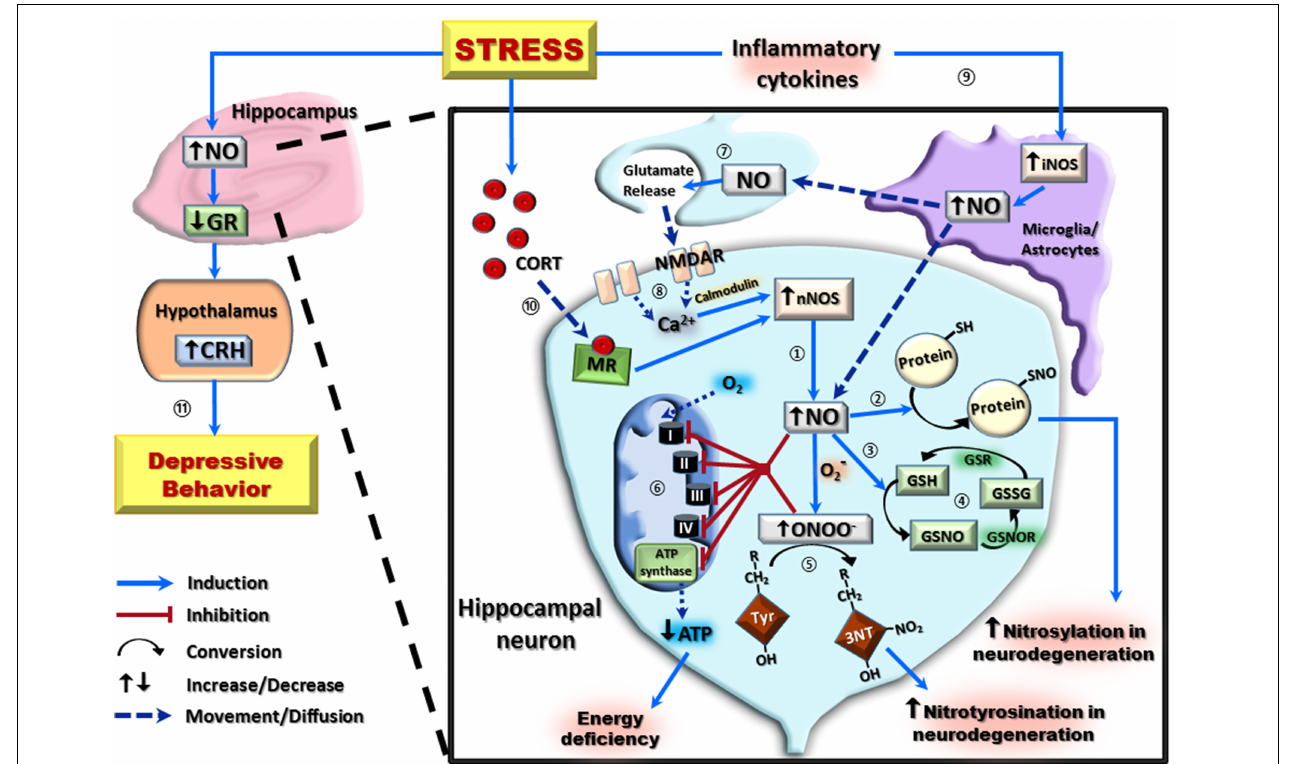
deficiency by inhibition of all components of the electron transport chain (Complex I–IV), including ATP synthase, resulting in decreased ATP production ⑥ . Both post-synaptically produced NO, and NO produced by the inducible isoform of nitric oxide synthase (iNOS), can act as a neurotransmitter on pre-synapticneurons ⑦ .Thispre-synapticNOcausesglutamaterelease,which activates post-synaptic NMDA receptors (NMDAR) to increase calcium (Ca 2 + ) concentration and, in the presence of calmodulin, further potentiate nNOS-derivedNO ⑧ .StressexposureincreasesNObyactivatinginflammatory cytokines to potentiate glial/astrocyte iNOS activity ⑨ , and by increasing circulating corticosterone (CORT) which induces nNOS activity via a mineralocorticoid receptor (MR)-mediated pathway ⑩ . This increase in NO results in downregulation of hippocampal glucocorticoid receptors (GR) and subsequently increases hypothalamic corticotropin-releasing hormone (CRH) to induce depressive-like behaviors (cid:2) 11